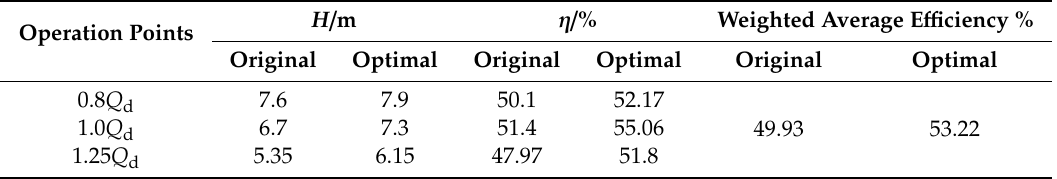
Table 8. Comparison of the performances under specified conditions.